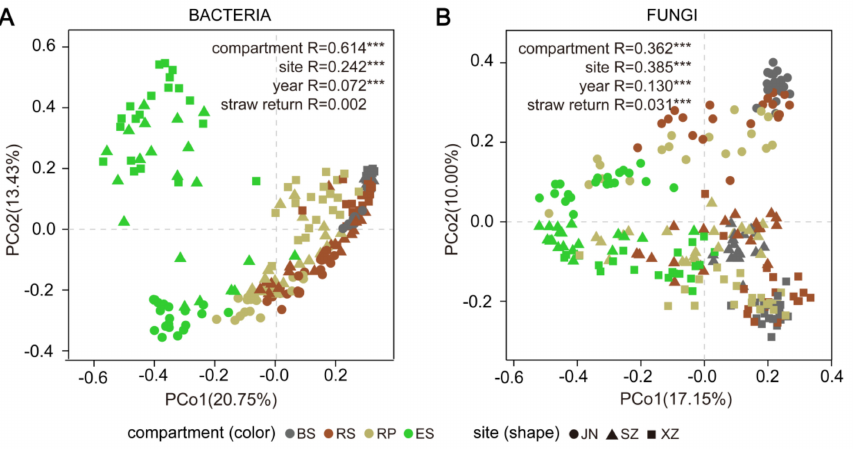
Figure 2. Principal coordinates analyses (PCoAs) showing the influence of compartment, site, year, and straw return on bacterial ( A ) and fungal ( B ) community composition based on Bray-Curtis dissimilarities. Analysis of similarities (ANOSIM) was applied to test for differences in community composition due to compartment, site, year, and straw return; R values are indicated with “***” for p <